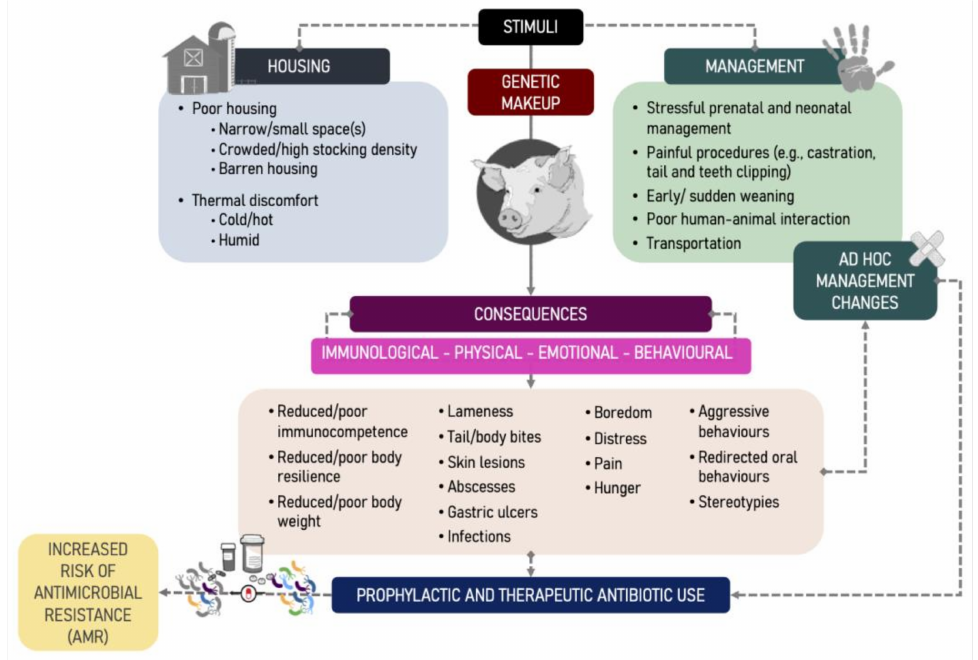
Figure 1. The biological pathway on how human-modulated stressors that challenge pigs’ immuno- logical, physical, emotional, and behavioural status act as risk factors (direct/indirect) for